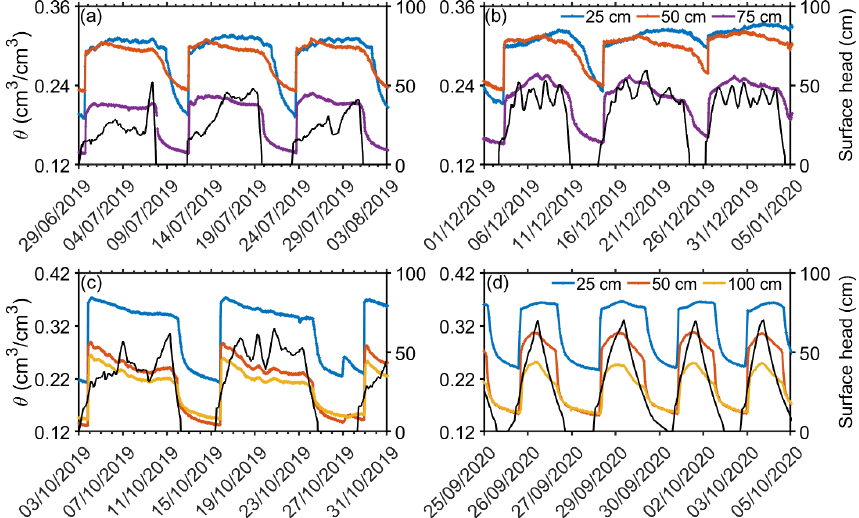
Figure 2. Representative time series of θ measurements obtained at station 2 (Fig. 1) during (a) summer and (b) winter under long wetting and drying cycles at three different depths. The black line represents the surface water hydraulic head. The bottom plots display θ measurements obtained at station 1 under (c) long and (d) short wetting and drying cycles during the summer.